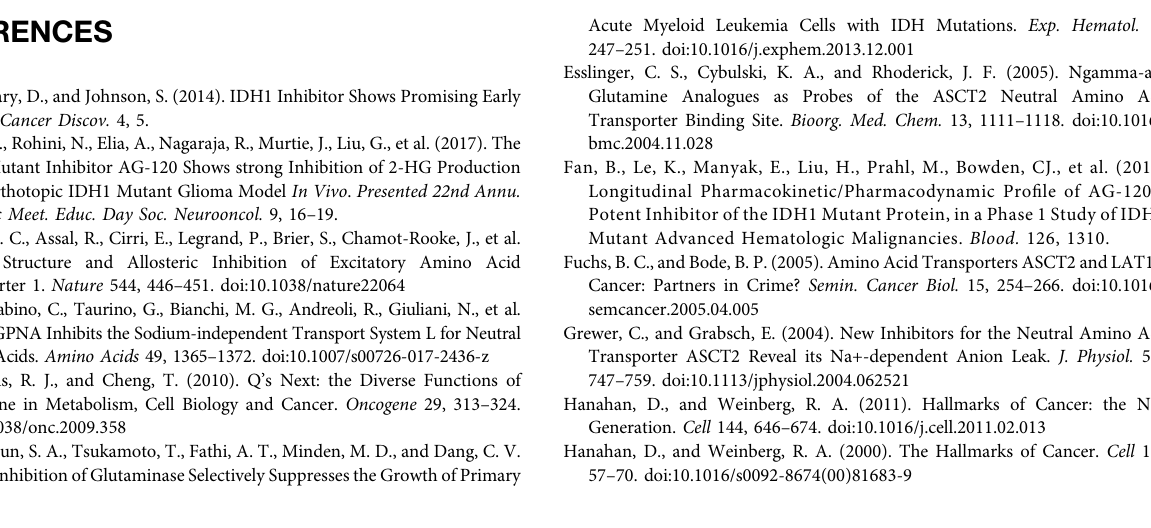
Supplementary Figure 1 | The combination of V9302 with ASCT2 and Effect of Ag120 on glucose uptake in CRC cells. (A) SPR analysis of the binding af fi nity of V9302 for puri fi ed ASCT2. (B) Glucose uptake was measured after incubation with Ag120 or V9302 for 40 min. Supplementary Figure 2 | Quanti fi cations of the indicated protein levels. The relative protein levels of ERK1 (A) , p-ERK1 (B) , p-mTOR1 b, m-TOR (D) , p-P70S6K (E) and P70S6K (F) in Figure 2G were quanti fi ed by Image-Pro Plus 6 software. Mean ± SD of 3 experiments. * P < 0.05, ** P < 0.01 by Student ’ s t -test. Supplementary Figure 3 | Quanti fi cation of autophagy induction by Ag120. (A,B) Autophagosome density (A) and lysosome density (B) were assessed by counting of cells labeled with MDC and LysoTracker dyes, respectively, after incubation with Ag120 or V9302 for 72 h. The relative protein levels of LC3 II (C) , LC3 II (D) , LAMP1 (E) , Beclin-1 (F) , ATG7 (G) and ATG5 (H) in Figure 3D were quanti fi ed by Image-Pro Plus 6 software. Mean ± SD of 3 experiments. * P < 0.05, ** P < 0.01 by Student ’ s t -test. Supplementary Figure 4 | Effects of Ag120 on CRC proliferation in glutamine-free medium. (A) The relative protein levels of IDH1 in Figure 4 (B) were quanti fi ed by Image-Pro Plus 6 software. (B – F) HCT116 and HT29 cells were treated with Ag120 (45 µM) for 72 h in DMEM medium containing 0 or 2 mM L -glutamine and then analyzed. (B) Cell numbers detected using a CCK-8 kit. (C) Colony formation quanti fi ed by light microscopy. (D) Relative contribution of Ag120 after glutamine depletiontoinhibition ofcolonyformation. (E) Quanti fi cation ofEdU incorporationby fl uorescence microscopy. (F) Relative contribution of Ag120 to inhibition of EdU incorporation after glutamine depletion. Mean ± SD of three3 experiments. * p P < 0.05, ** p P < 0.01 by Student ’ s t -test. Supplementary Figure 5 | Effects of Ag120 on glutamine metabolism and proliferation of CRC cells after ASCT2/SLC1A5 knockdown or overexpression. (A,B) RT-qPCR analysis of SLC1A5 mRNA levels in ASCT2-knockdown (A) and ASCT2-overexpressing (B) HCT116andHT29cells. (C,D) Therelativeproteinlevels of ASCT2 in Figure 5 (A,B) were quanti fi ed by Image-Pro Plus six6 software. (E,F) Glutamine uptake in ASCT2-knockdown (E) and ASCT2-overexpressing (F) HCT116 and HT29 cells treated with Ag120 (15 µM) for 2 h. (G,H) As described for (E,F) except cell numbers were quanti fi ed using a CCK-8 kit. (I,K) Colony formation by ASCT2-knockdown (I) and ASCT2-overexpressing (K) HCT116 and HT29 cells after Ag120 (45 µM) treatment for 10 days. (J,L) Relative contribution of Ag120 treatment to inhibition of colony formation in ASCT2-knockdown (J) and ASCT2-overexpressing (L) cells. Mean ± SD of 3 experiments. * p P < 0.05, ** p P < 0.01 by Student ’ s t -test. Supplementary Figure 6 | Quanti fi cation of Ag120-mediated inhibition of ASCT2 expression, proliferation, and autophagy in HCT116 xenografts in vivo . (A – D) Figure 6A for experimental protocol. Tumors were excised on day 28 and positively stained cells were quanti fi ed. (A) EdU-incorporating cells measured by fl uorescence microscopy. (B – D) Intensity of immunohistochemical staining of ASCT2 (B) , Ki67 (C) , and LC3 (D) expression. Mean ± SD of 3 experiments. * P < 0.05, ** P < 0.01 by Student ’ s t